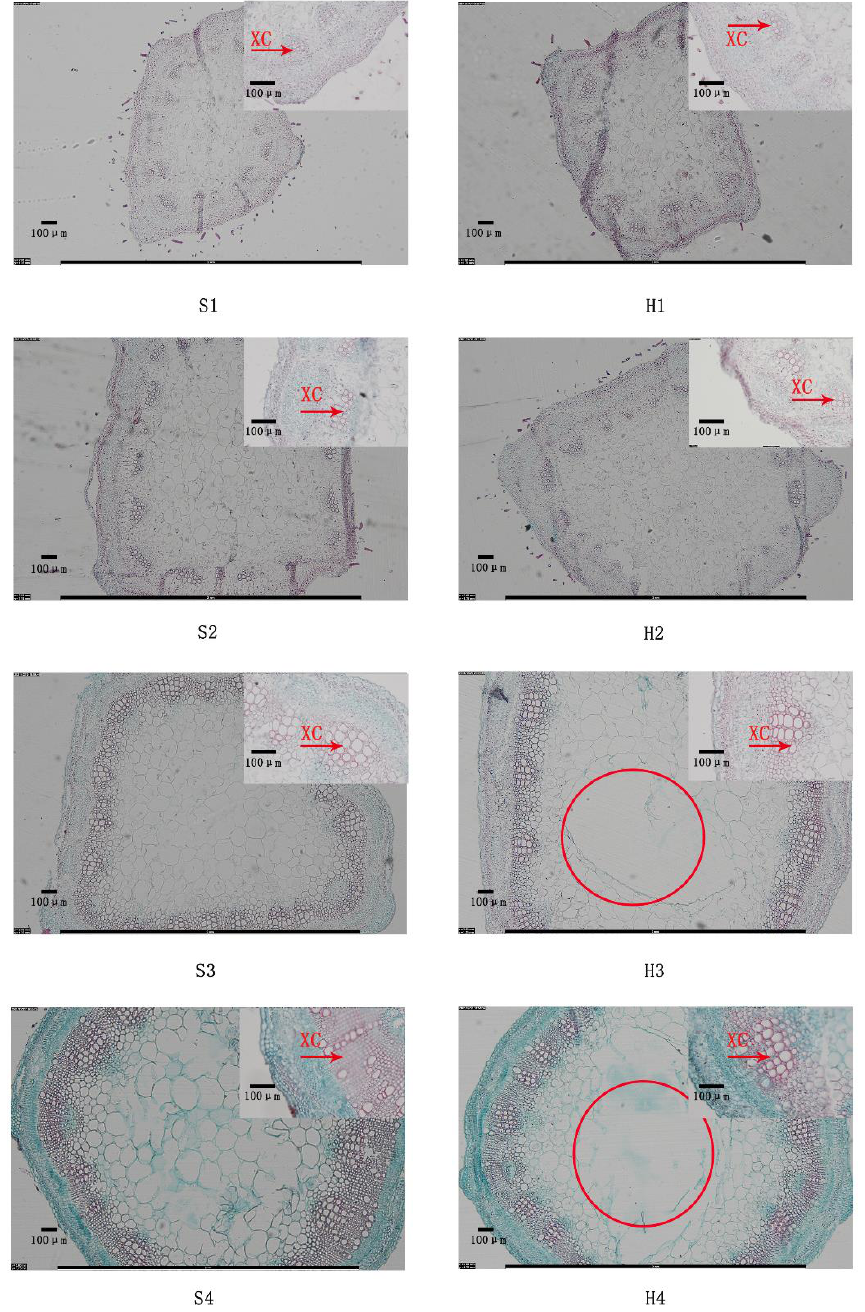
Figure 3. Transverse sections at stems of two alfalfa cultivars in four developmental stages. XC, xylem cell. The red circle represents intracellular space. S1–S4 represent four stages of development in Zhungeer. H1–H4 represent four stages of development in WL168.